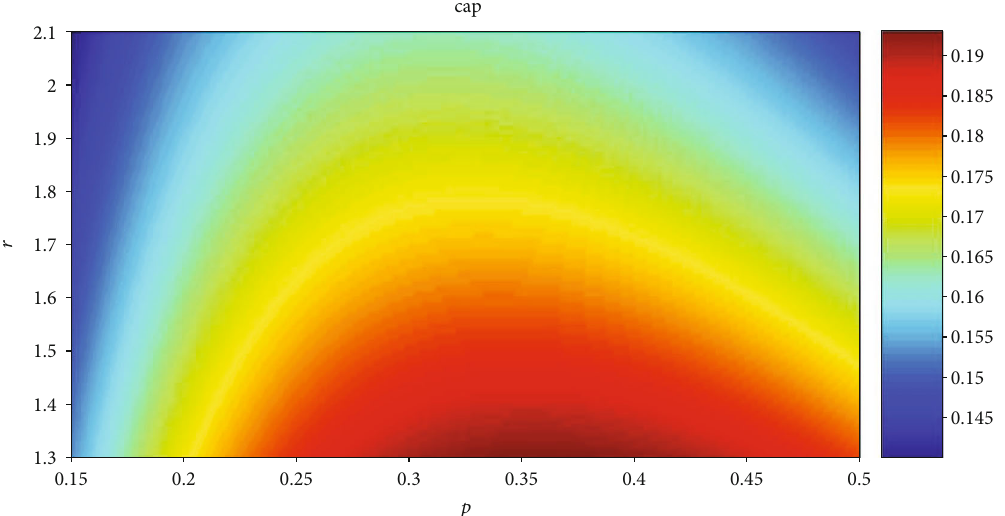
Figure 14: The relationship between cap and p and r